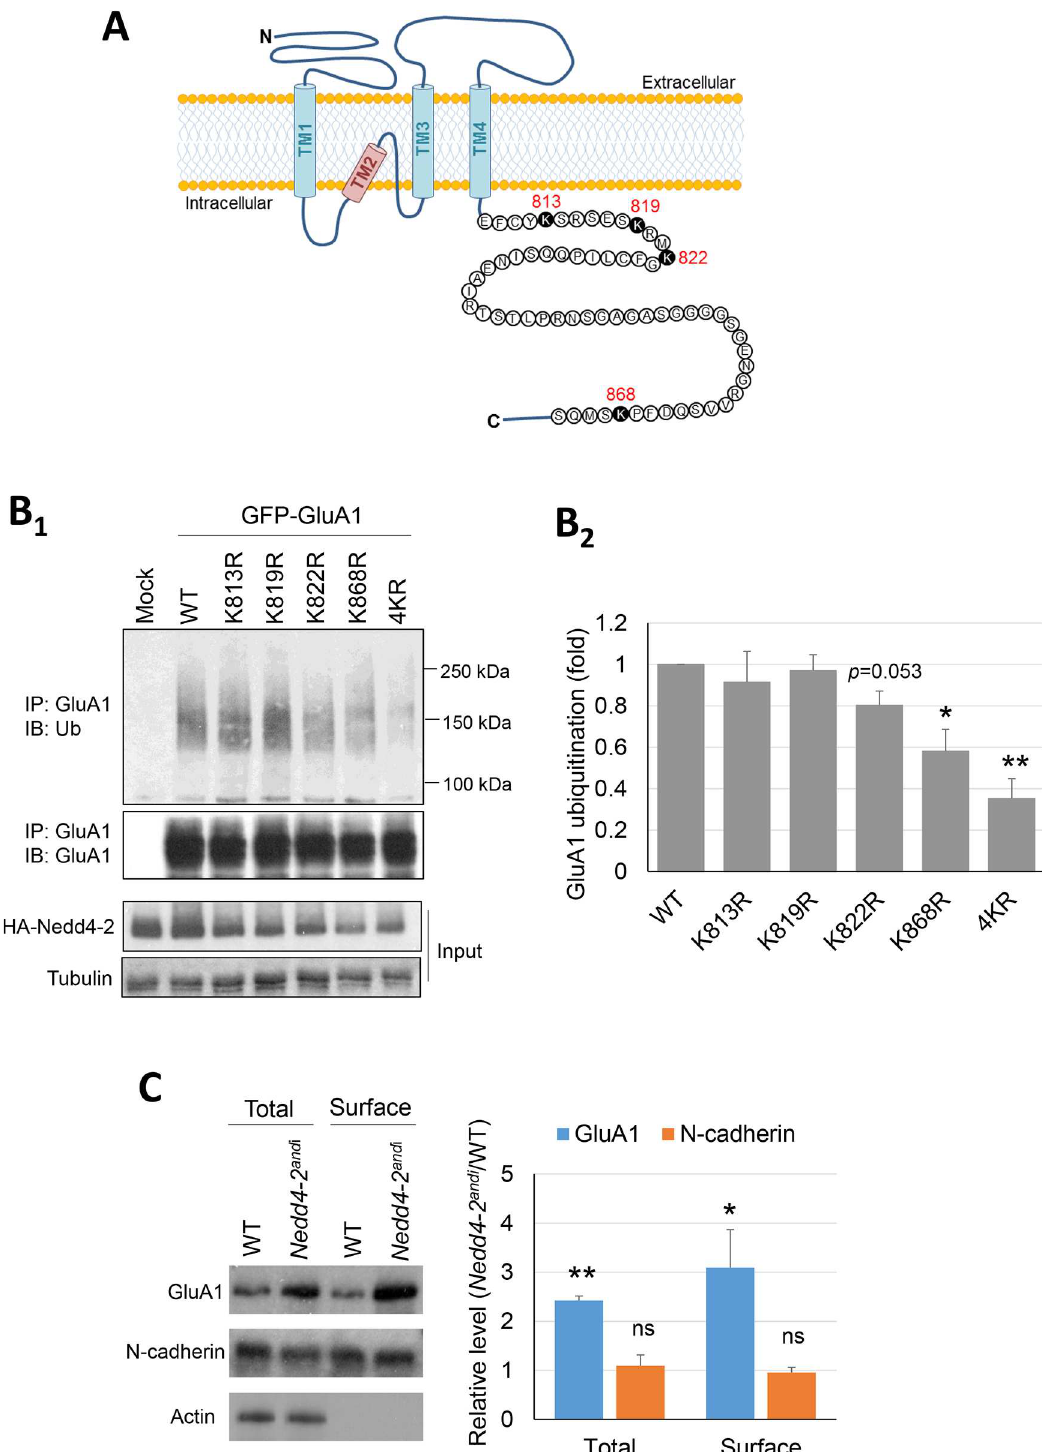
Fig 5. Nedd4-2 mediates surfaceexpressionof GluA1. ( A ) Illustration of GluA1 on the cell membraneand the 4 lysine residues potentially ubiquitinated by Nedd4-2at the C-terminus of GluA1. ( B 1 ) Western blots of Ubiquitin(Ub) or GluA1 after immunoprecipitation using anti-GluA1 antibody from HEK cells transfected with WT HA-Nedd4-2 along with WT GluA1 or mutant GluA1s (K813R, K819R, K822R, K868Rand 4KR) for 48 hours. Quantification of ubiquitinatedGluA1 by the area of smear from 100–250 kDa is shown on the right ( B 2 ) (n = 4, one-wayANOVA with post-hoc Tukey test). ( C